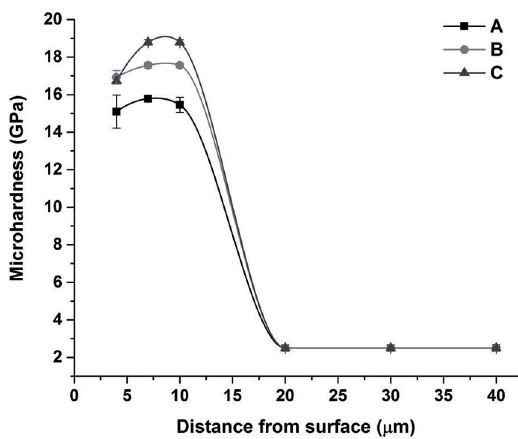
Figure 6: Cross-sectional microhardness profiles. A - Chromizing, B – Chrome–boronizing–siliconizing (obtained using the mixture 2) and C - Chrome–boronizing–siliconizing (obtained using the mixture 3).